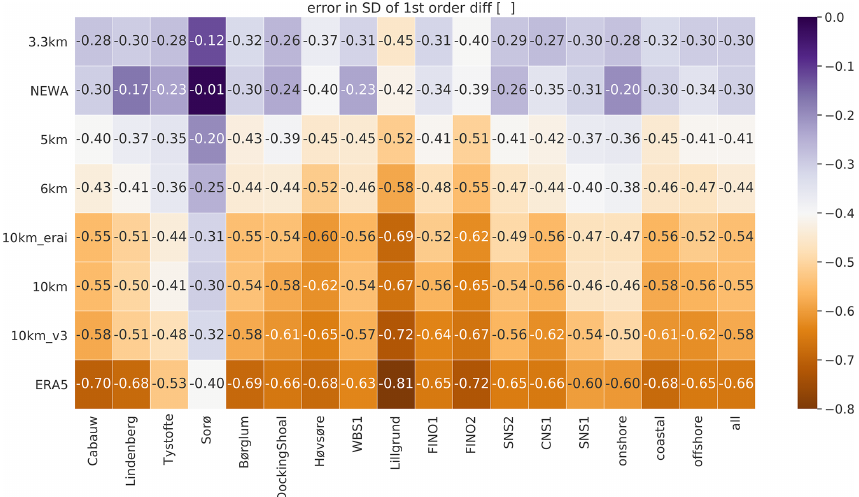
Figure 5. Error in the standard deviation of first difference (SD of first diff) between the simulated time series and the measurements for the various experiments in Table 1 and reanalyses. The darkest purple colours are the best results; the darkest brown is the worst. The rows are sorted by the column median all, with the most accurate results on the top and the least accurate results on the bottom of the table.